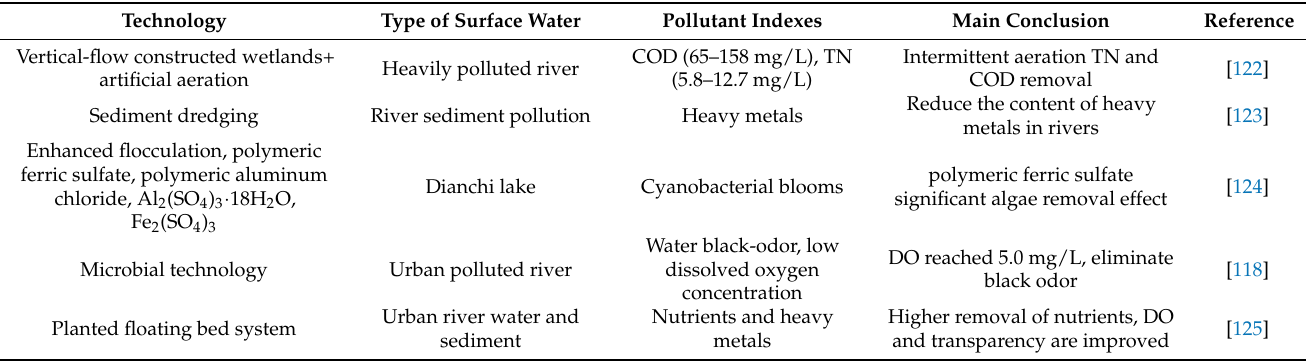
Table 4. Remediation technology and application of surface